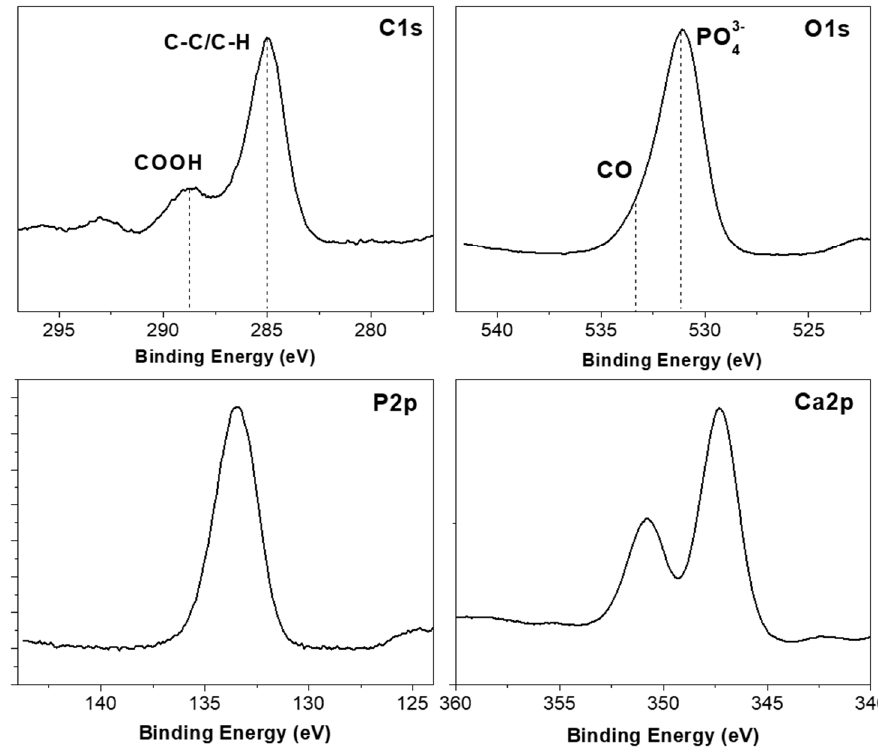
Figure 7. High resolution XPS spectra of the HA surface: carbon C1s, oxygen O1s, phosphorus P2p and calcium Ca2p regions. Guidelines mark the main functional groups.